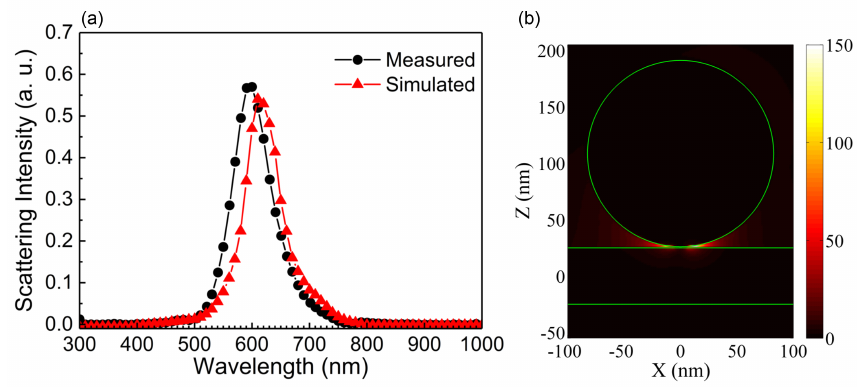
Figure 5. ( a ) Measured and calculated scattering spectra for the Ga NP with d = 165 ± 2 nm which was excited by the SPPs generated at an incidence angle of θ = 46.5 ◦ . ( b ) The calculated XZ plane electric field distribution | E | for the Ga NP at the scattering peak.